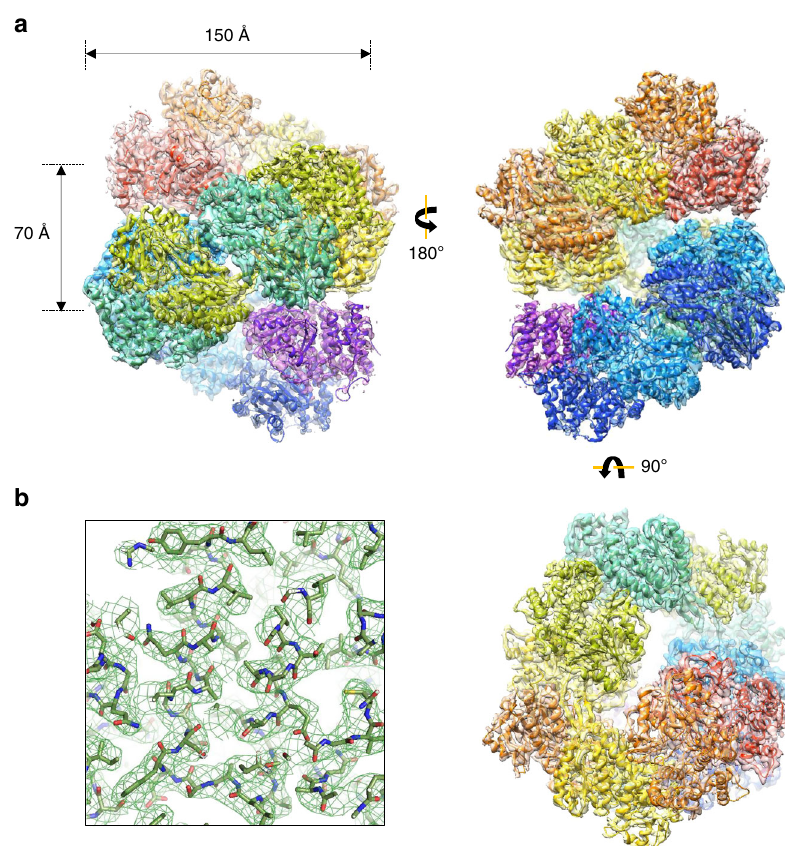
Fig. 2 AdhE forms a spirosome structure. a The cryo-EM structure of AdhE with six AdhE and two ADH domains fi tted to the cryo-EM map. Each AdhE subunit is in a different colour. The structure is viewed from different angles (left, right and below). b The cryo-EM map with the re fi ned